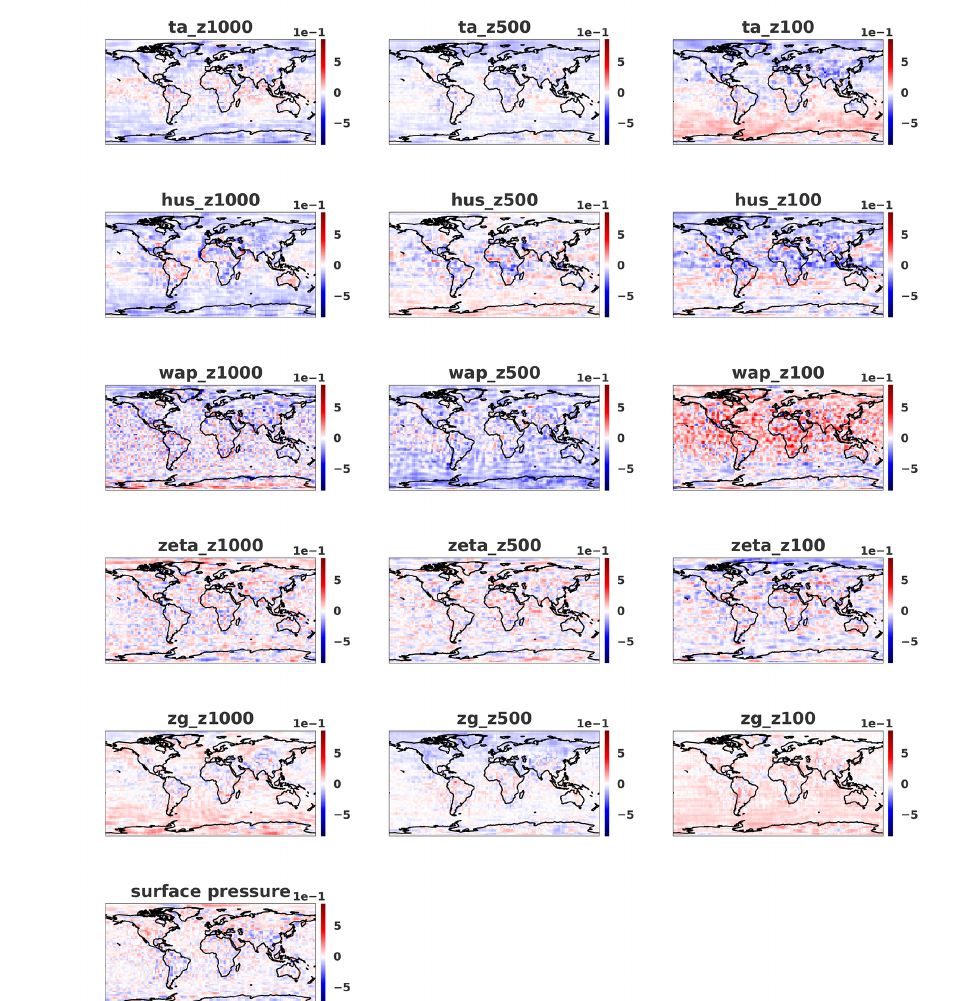
Figure 10. Mean error over 30 years of the normalized dataset and the same number of normalized generated samples on three different pressure levels (1000, 500 and 100hPa). The samples were horizontally transposed in order to have Europe at the center of the images. Coastlines were added a posteriori for